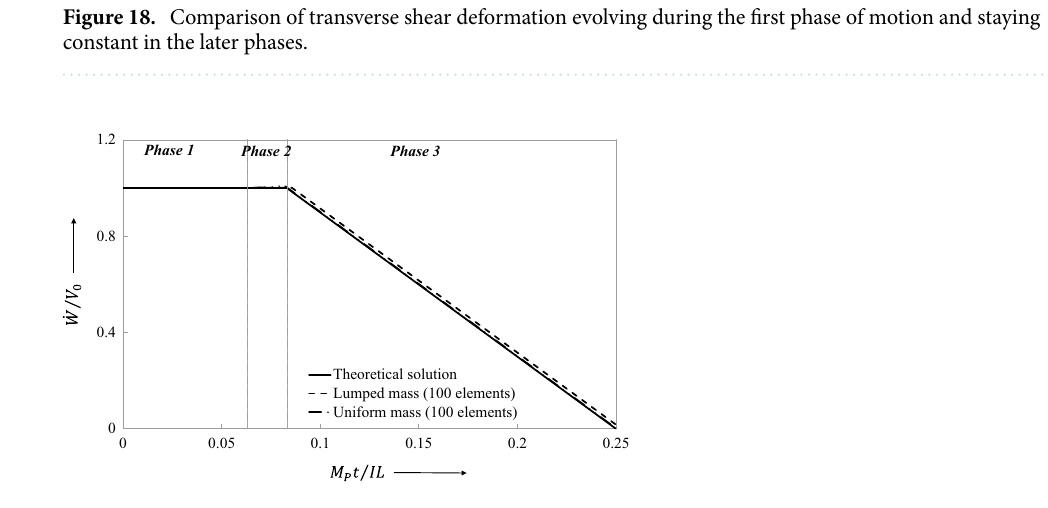
Figure 19. The variation of transverse central velocity, constant in Phase 1 and Phase 2 of motion, and plummeting in Phase